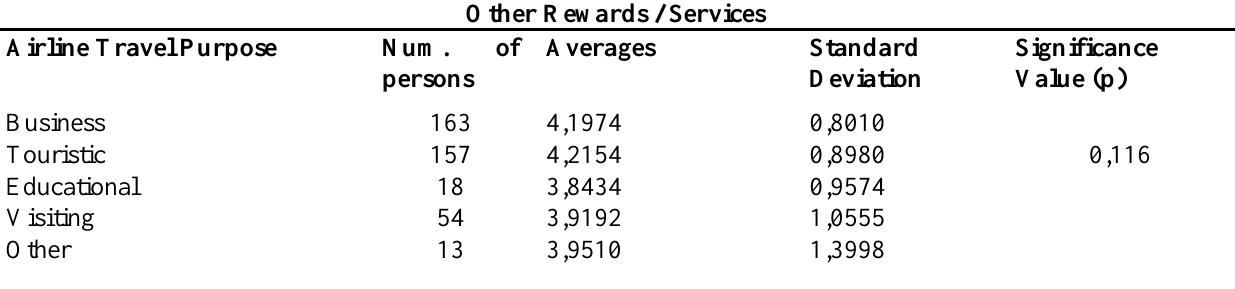
Table 13. Comparison of the views regarding the perception level of the rewards / services offered within FFPs according to the purpose of travel Other Rewards /